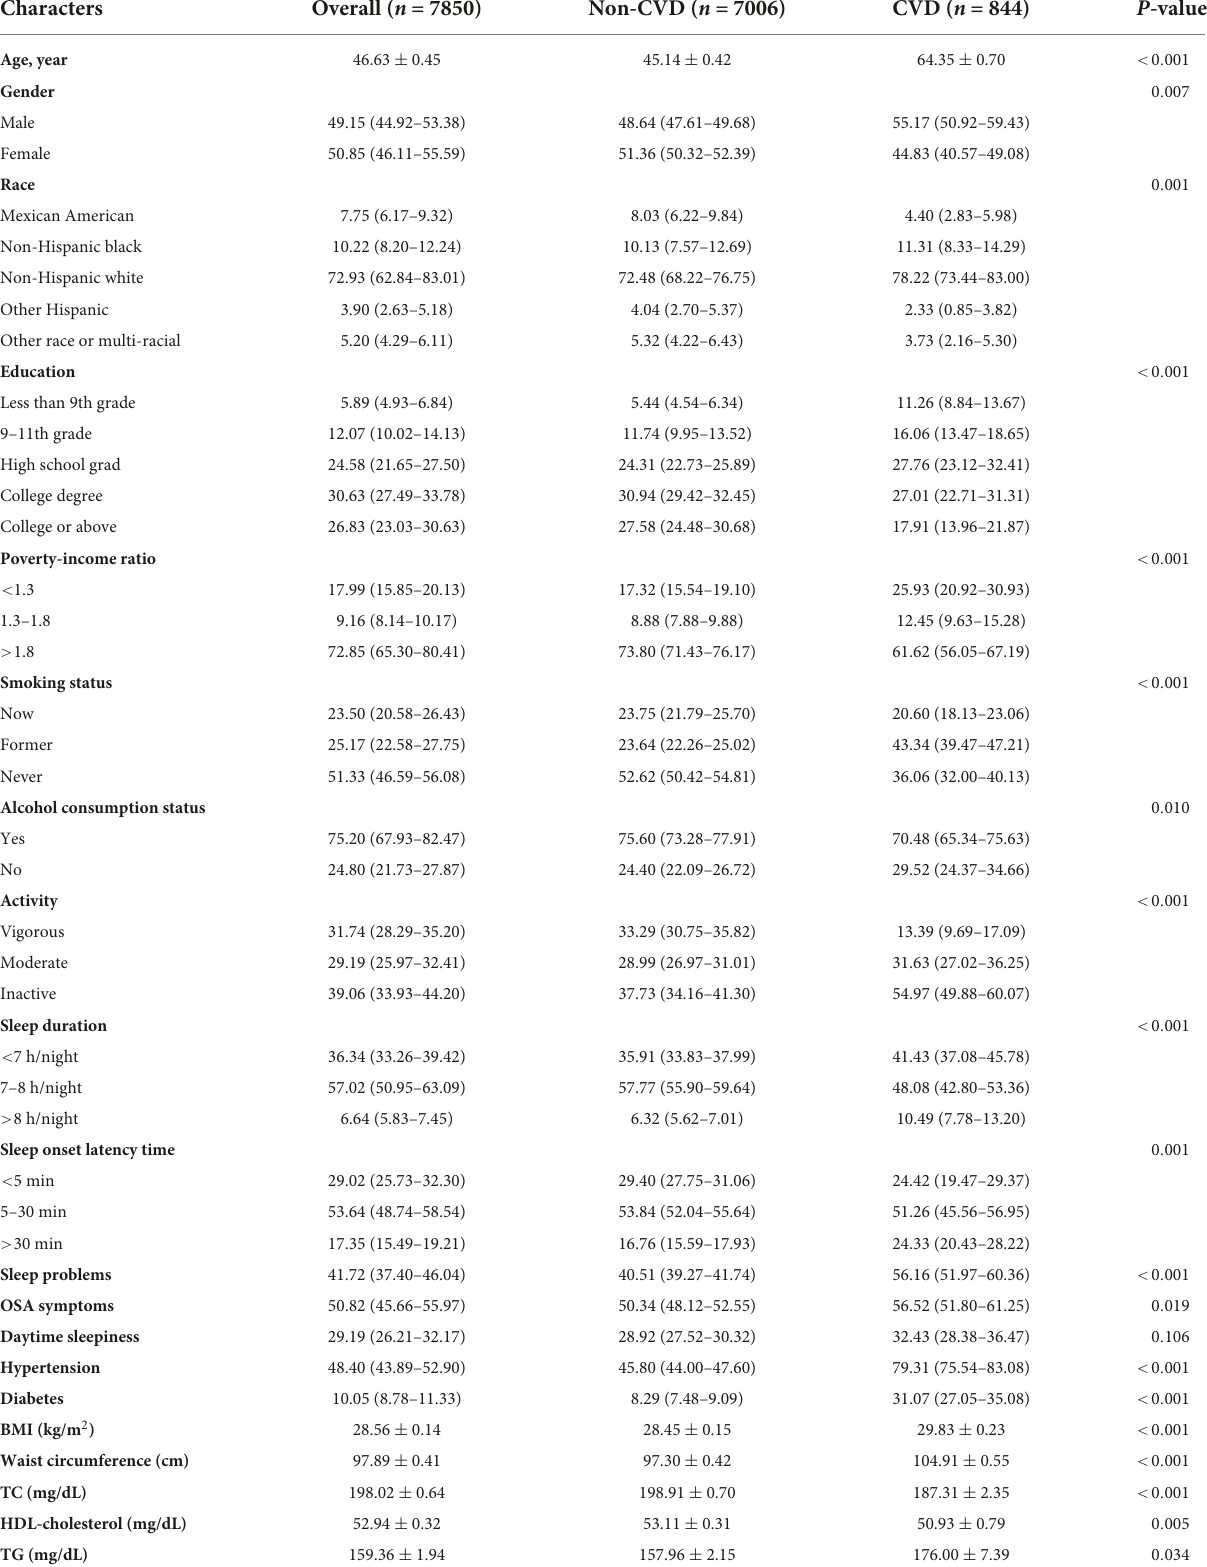
Values indicate the weighted mean ± SD or weighted% (95% confidence interval). P -values are weighted. OSA, obstructive sleep apnea; BMI, body mass index; TC, total cholesterol;